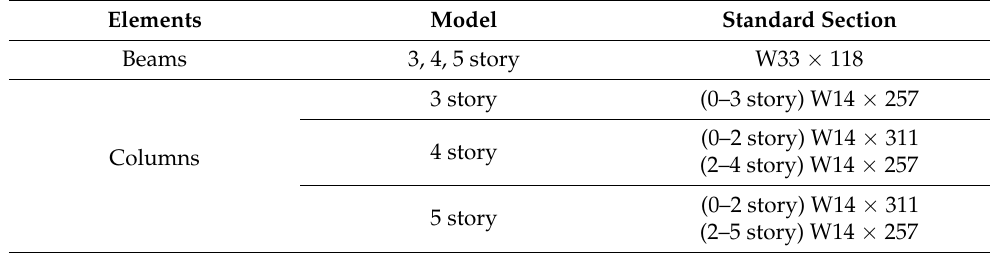
Table 1. Details of the cross-sections of the